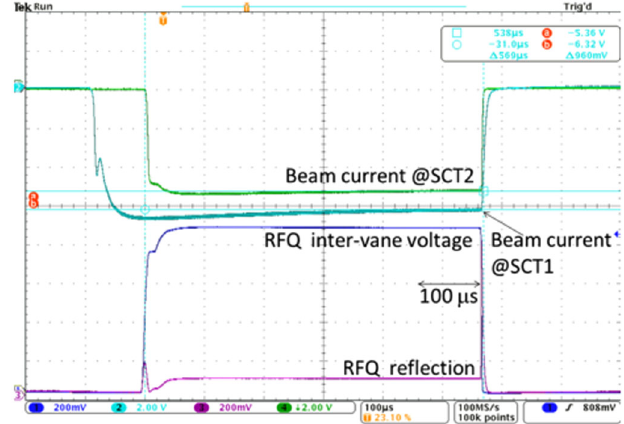
FIG. 8. Typical wave form of the 500 μ s pulse operation. Repetition rate of this operation was 5 Hz.